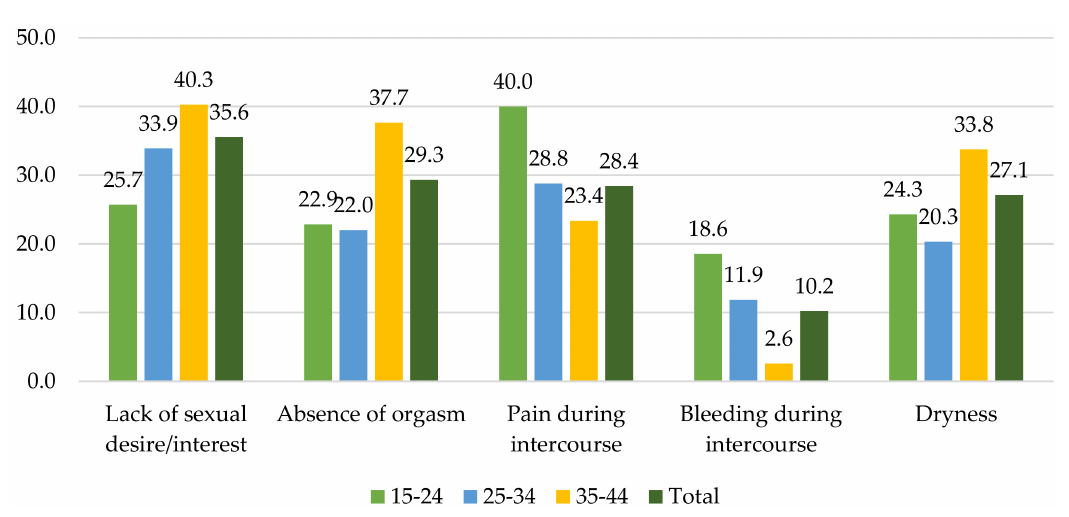
Figure 4. Types of sexual dysfunction